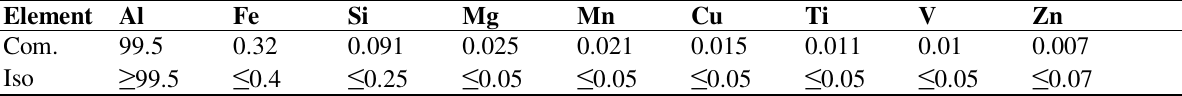
Chemical composition of the aluminum sheet (Al1050) (% of mass). Element